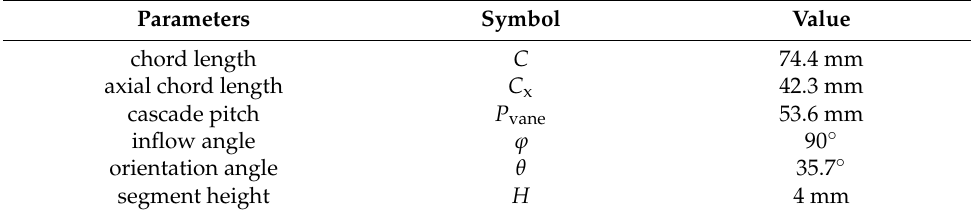
Figure 1. Schematic of the turbine guide vane and coolant injection position. ( a ) turbine guide vane, ( b ) coolant injection position on the vane surface. Table 1. Main parameters of the turbine guide